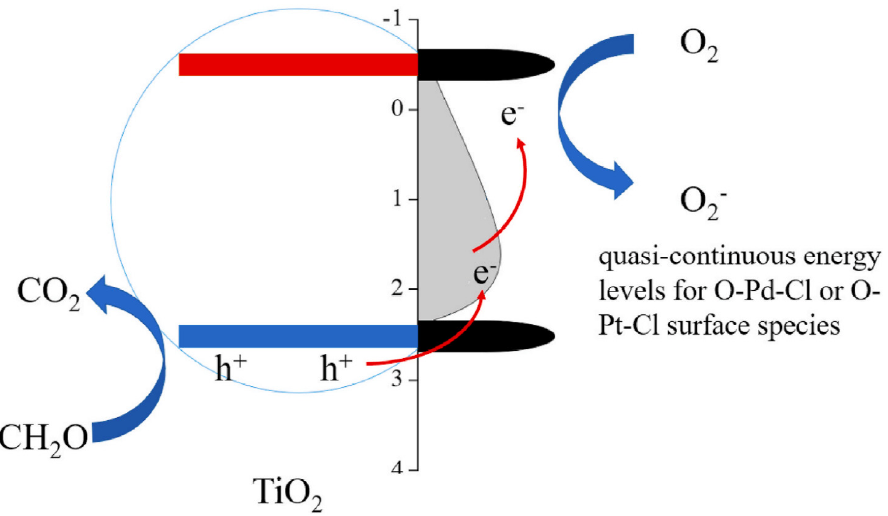
Figure 14. Schematic diagram depicting the thermal catalysis mechanism of a TiO 2 -M (M = Cu, In, Pd, and Pt) catalyst. Reprinted/adapted with permission from Ref. [291]. 2021,